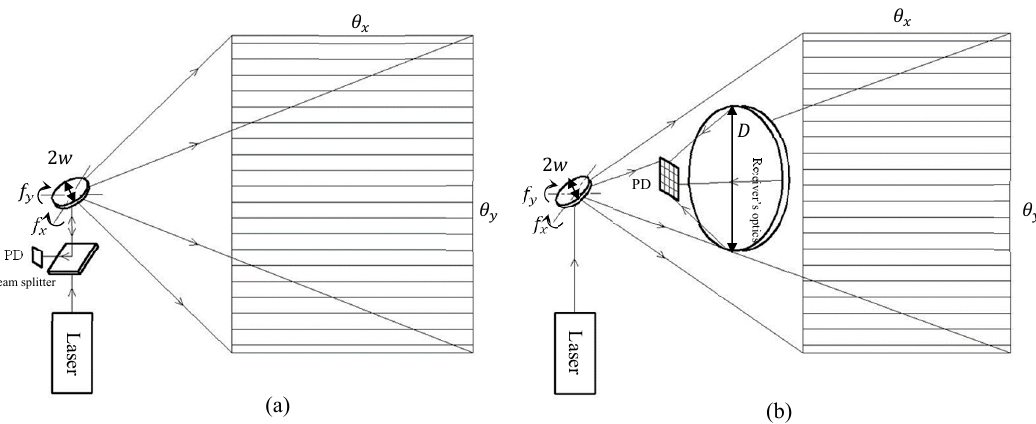
Figure 3. The schematics of MEMS scanned LiDAR with ( a ) coaxial architecture, and ( b ) non-coaxial architecture. 2w : the dimension of the MEMS mirror plate. f x , f y : the horizontal and vertical scanning frequency of the MEMS mirror. θ x and θ y : the horizontal and vertical optical scanning FoV. D : the dimension of the receiver’s optical aperture.